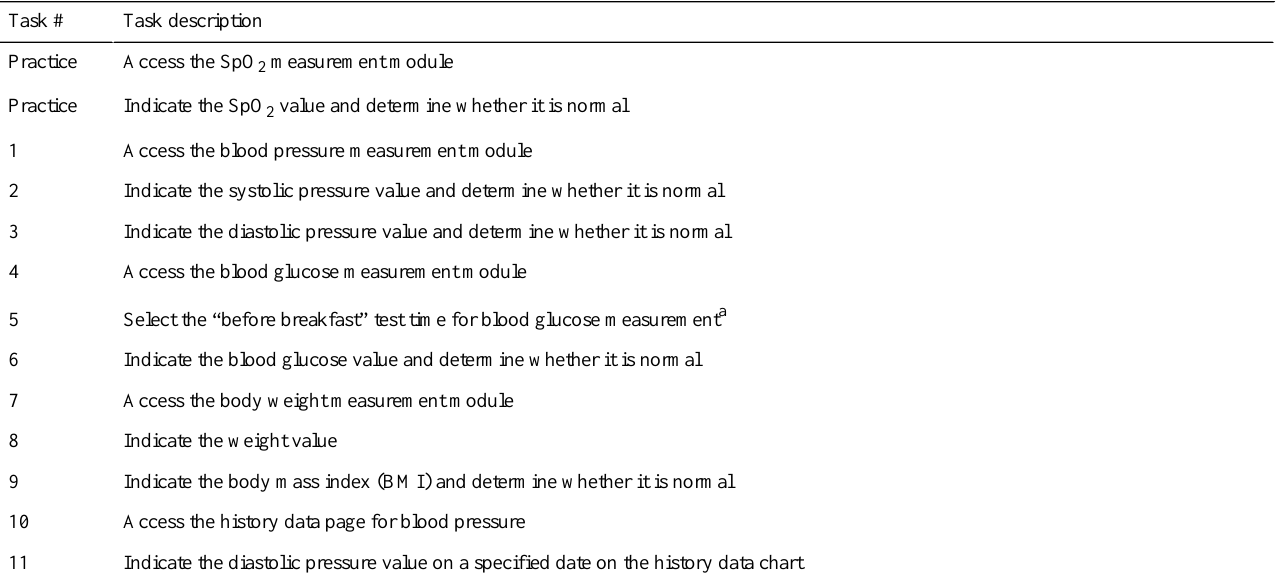
Table 2. Self-management tasks used during end-user testing. Task descriptionTask